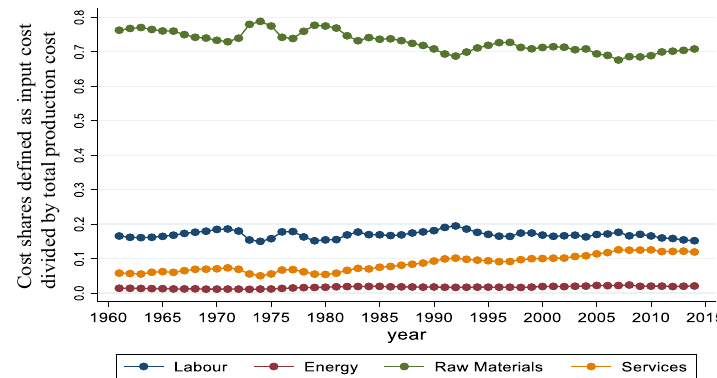
Fig. 6 Trends in estimated cost shares for variable